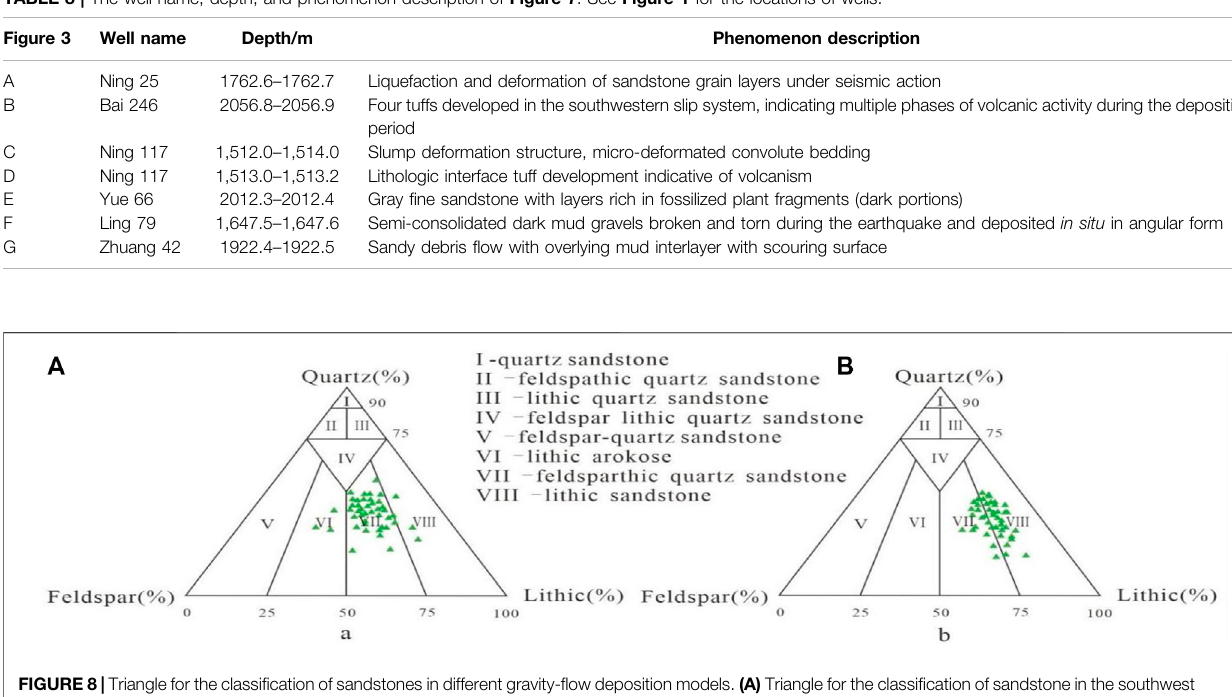
Frontiers in Earth Science |